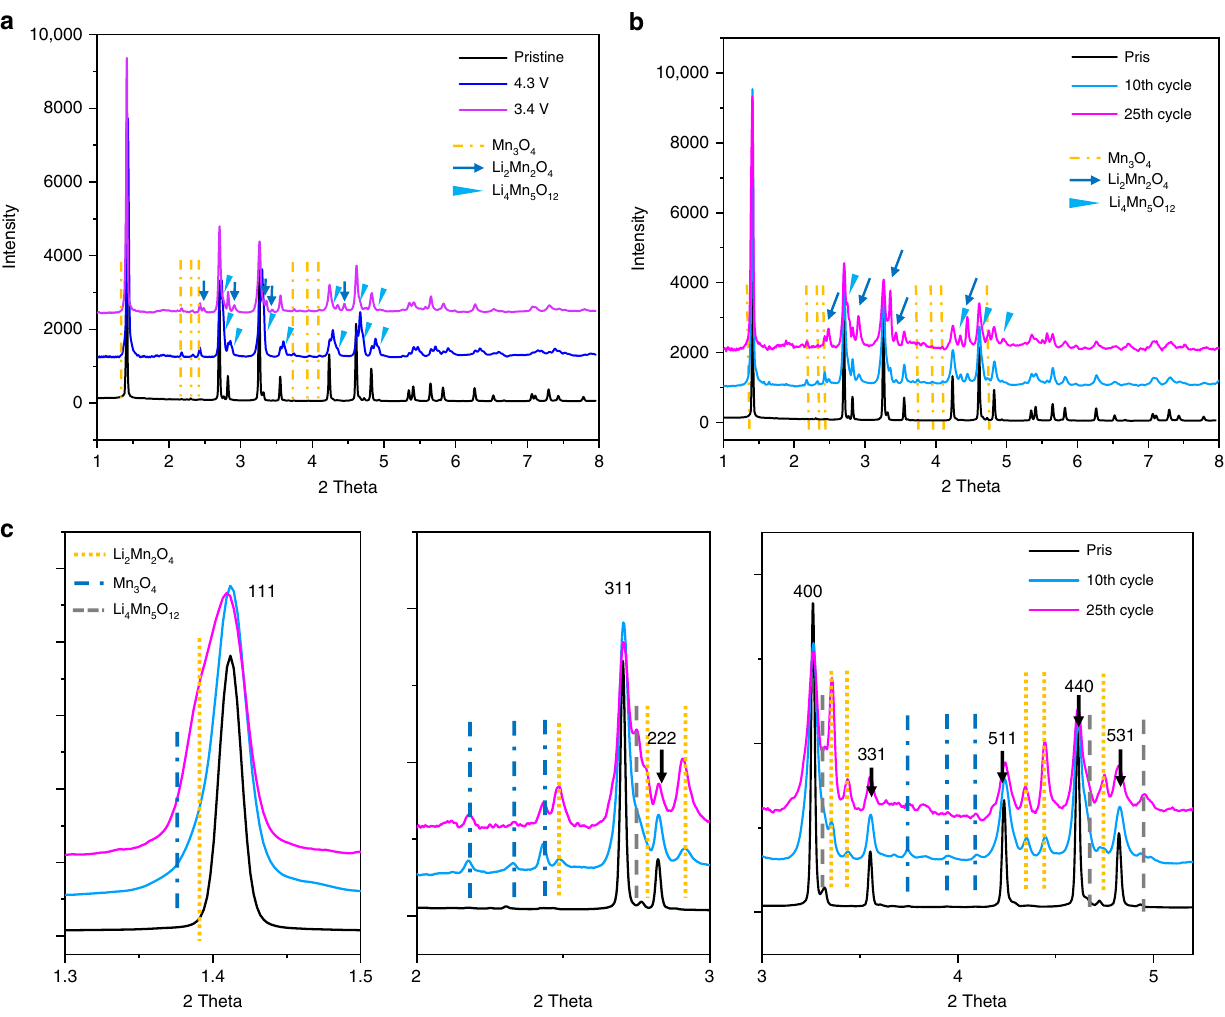
Fig. 2 Qualitative structural analysis of LMO with different potentials and cycles. a Ex situ XRD pattern of LMO at different potentials. b Ex situ XRD patterns of LMO at different cycles. c The enlarged fi gures of the red dashed rectangles of